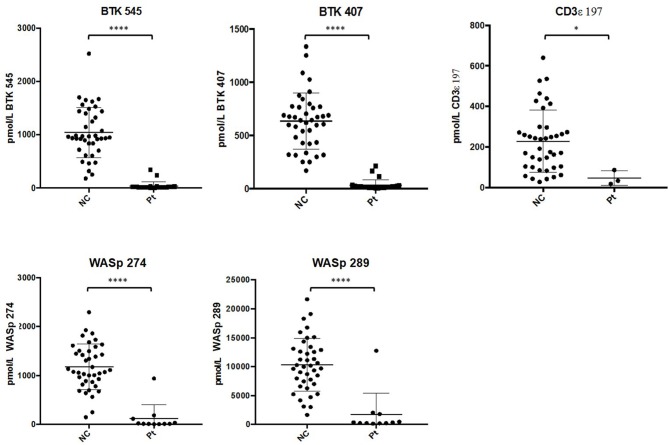
Differences in signature peptide levels between patients (WAS: n = 11, XLA: n = 26, SCID: n = 3) and normal controls (n = 40). Error bars indicate mean ± SD. WAS patient sample with high levels of WASp peptides was identified to be collected after bone marrow transplantation. ****p < 0.0001, *p < 0.05.